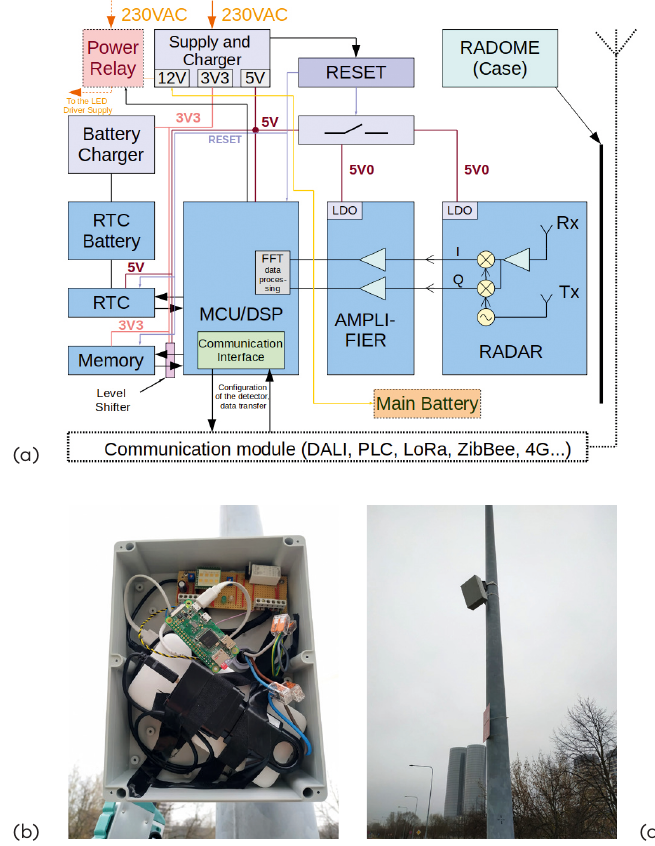
Figure 19. Radar sensor for experimental verification: (a) block schematics; (b) and (c) practical